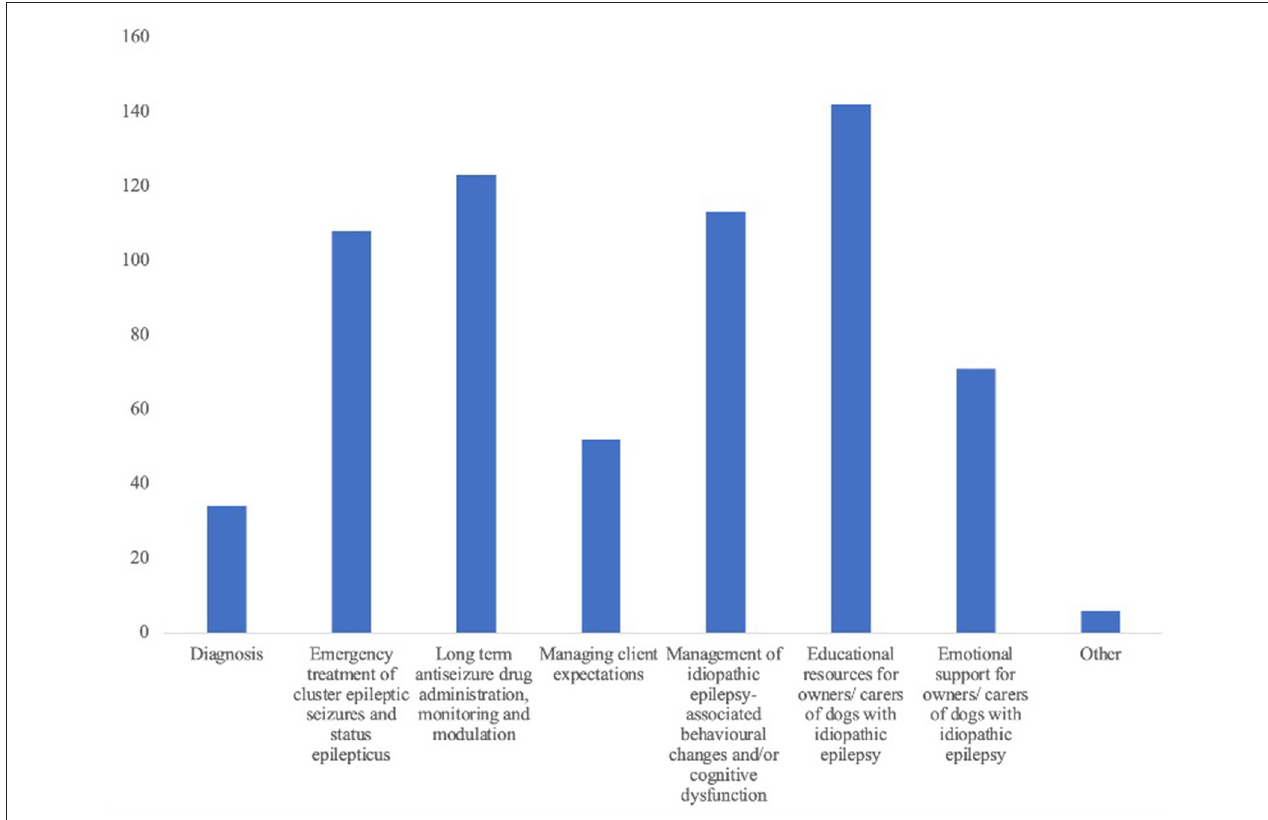
FIGURE 4 | A bar chart displaying in which aspects of canine idiopathic epilepsy the 235 respondents would like more training and support to be provided.